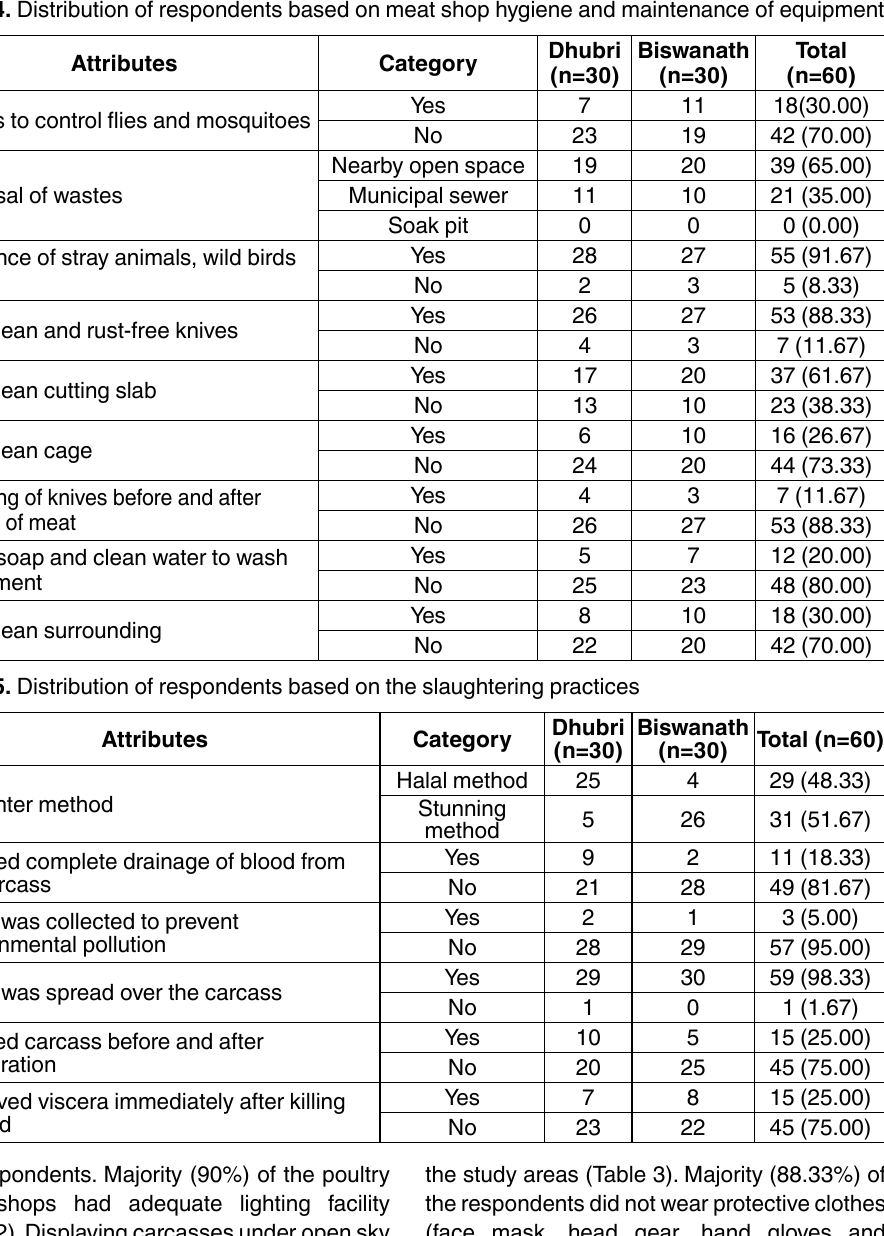
table 4. Distribution of respondents based on meat shop hygiene and maintenance of equipment Attributes category Means to control flies and mosquitoes Nearby open space Disposal of wastes Presence of stray animals, wild birds etc. Had clean and rust-free knives